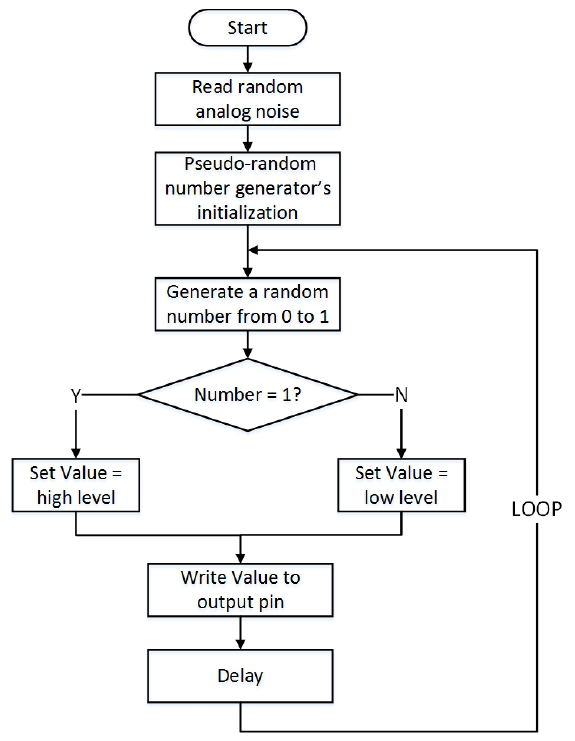
Figure 9. Flow chart of pseudo random sequence’s generation.